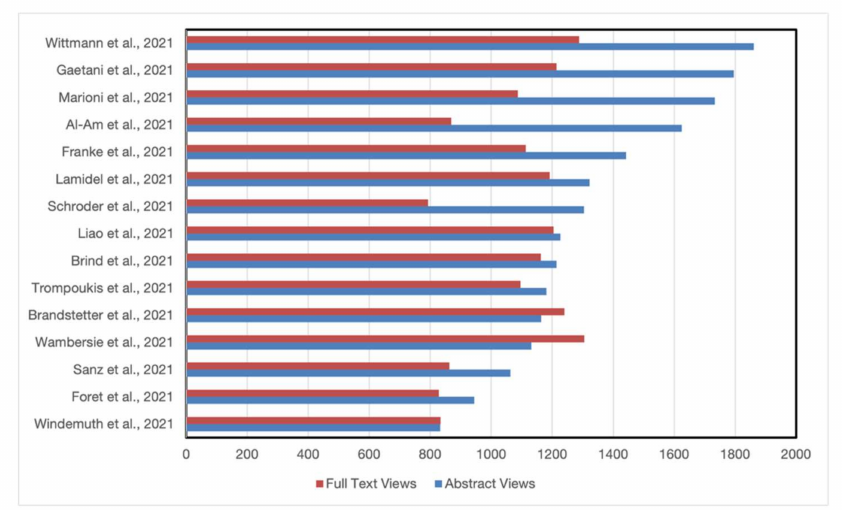
Figure 1. Article access statistics gathered over one year of open access exposure; Brind and